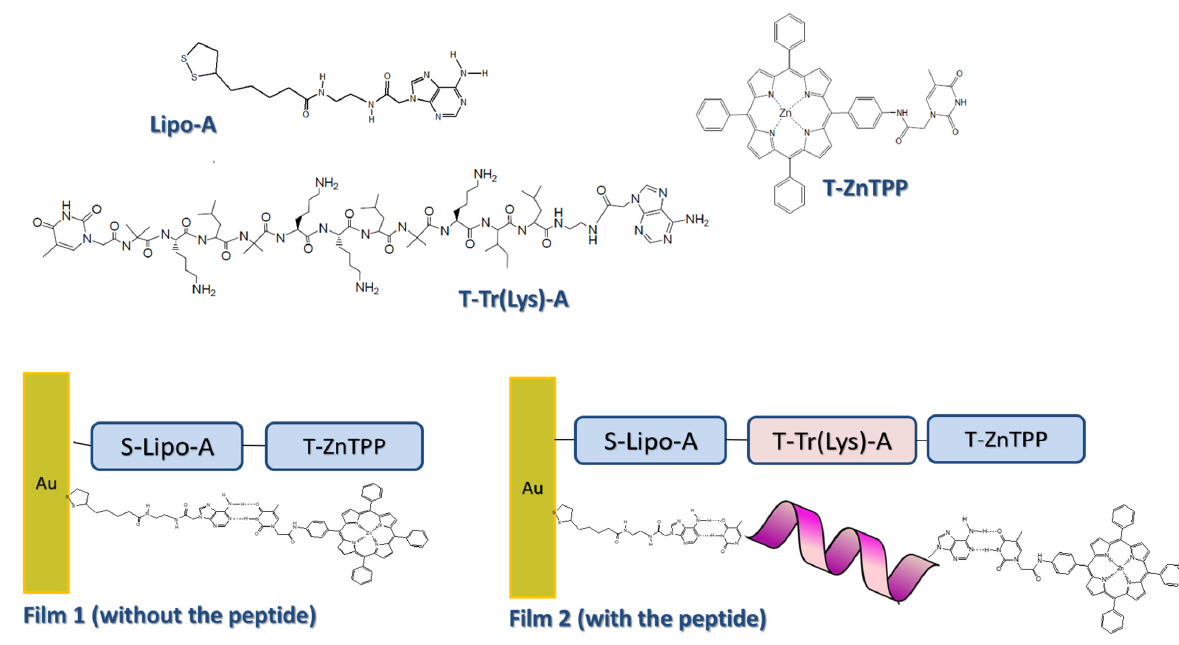
Figure 3. Chemical structures of the building blocks used for the construction of films reported in ref. [85].